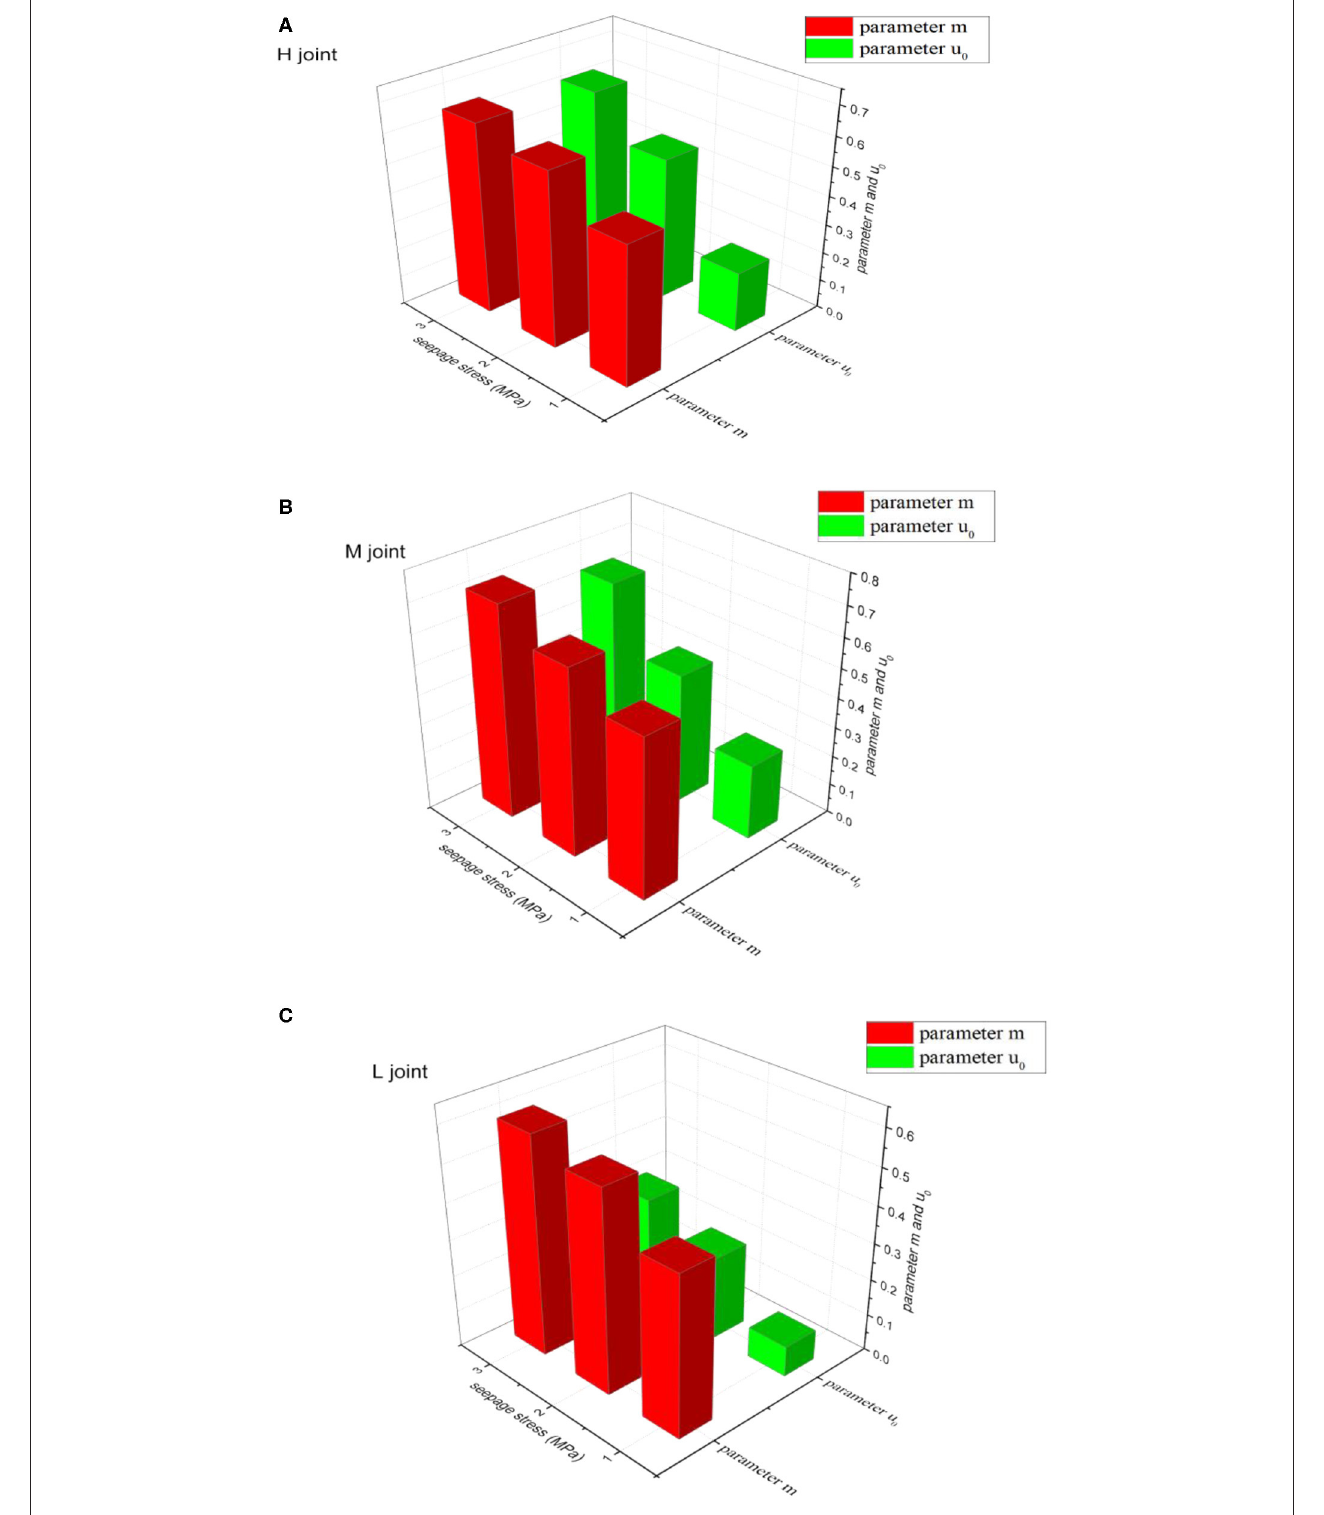
FIGURE 11 | The relationship between seepage pressure and model parameters m and u 0 . (A) H joint (B) M joint (C) L joint.